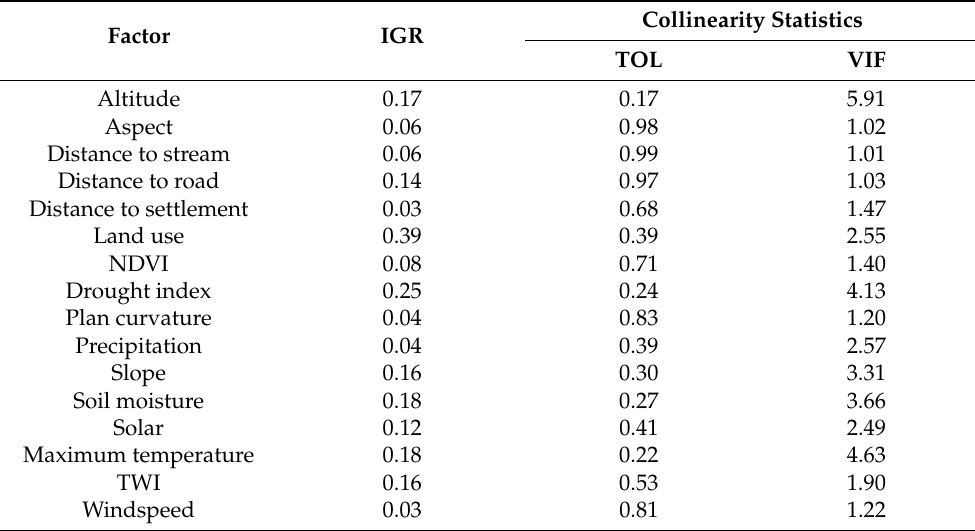
Table 4. IGR and multicollinearity results for the conditioning